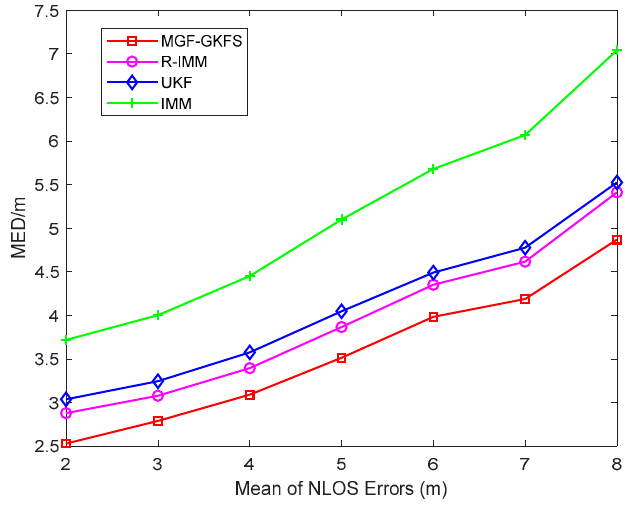
Figure 7. The MED versus mean of NLOS errors.